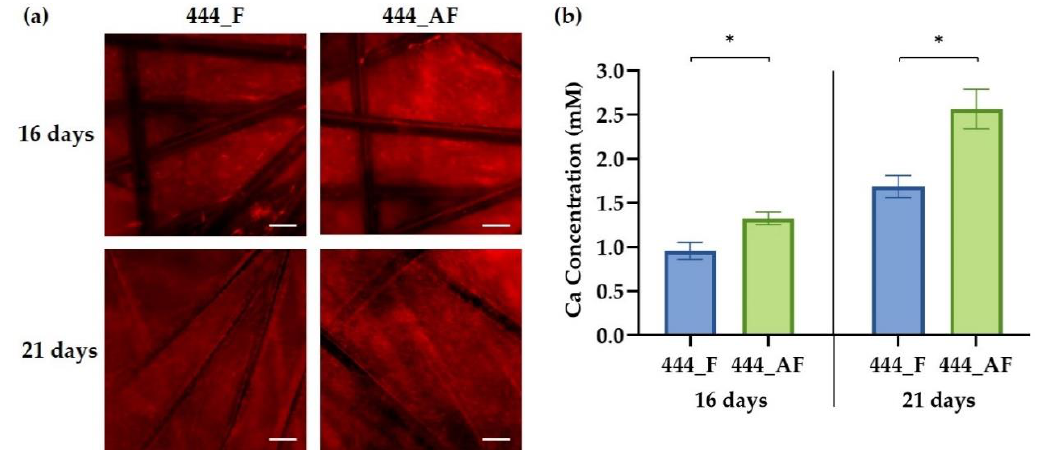
Figure 6. ( a ) Fluorescence imaging of calcium-rich deposits, stained with Alizarin Red, of 444_F and 444_AF scaffolds at days 16 and 21 of culture. Red areas indicate positive staining for calcium-rich deposits (scale bar—100 µm); ( b ) Calcium concentration at days 16 and 21 for the tested groups measured from the released Alizarin red dye using a plate reader at 405 nm. Bars represent the mean ± standard error for each tested group ( n = 3 samples from each group). Statistical analysis was conducted by unpaired t test, * p < 0.05.